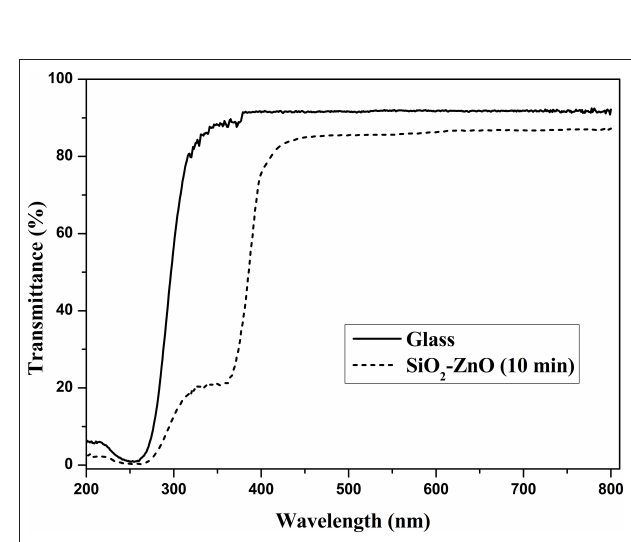
FIGURE 11 | Transmittance spectra of SiO 2 shell on ZnO nanorod arrays and bare glass.